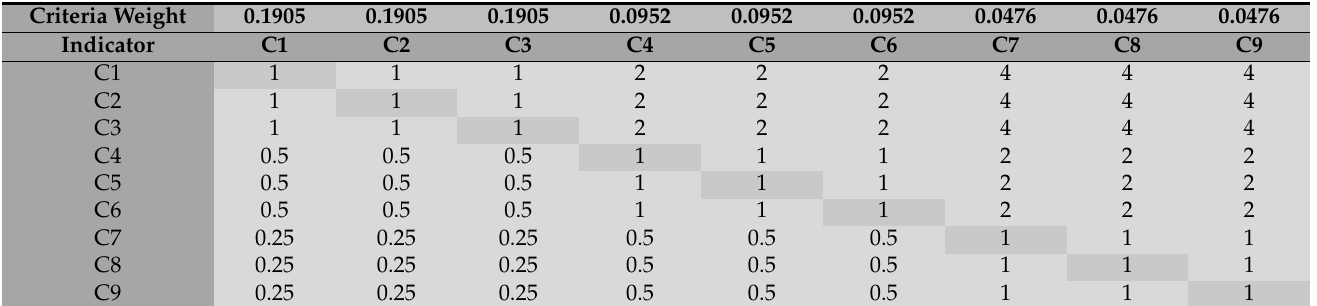
Table 3. Pairwise comparison matrix. C1—ploughing fuel consumption, C2—disc harrowing fuel consumption, C3—yield, C4—CO 2 from soil, C5—soil density, C6—yotal porosity, C7—humus, C8—stability, and C9—moisture. Criteria Weight 0.1905 0.1905 Indicator